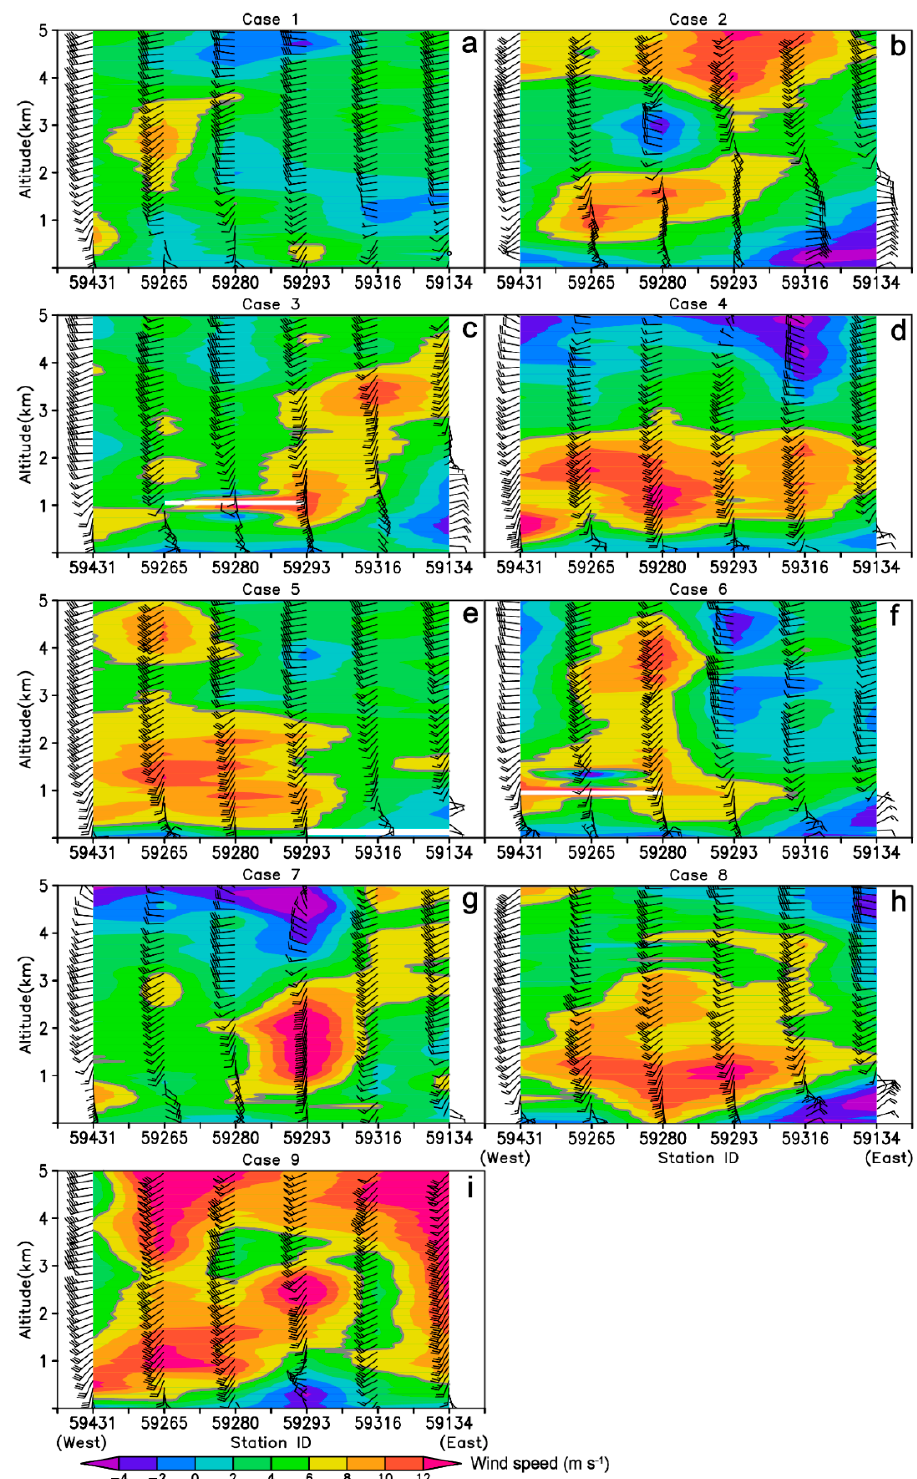
Figure 4. Vertical sections of wind speeds (color-shaded; units: m s − 1 ) and vectors along radiosonde